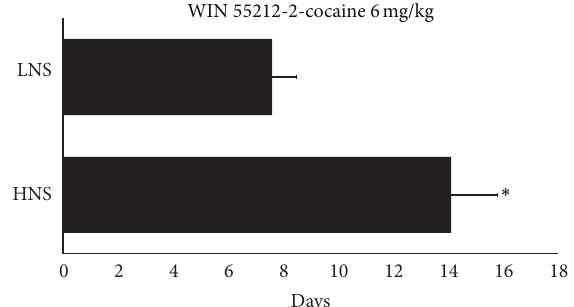
Figure7: Effectsof thenovelty-seeking phenotypeontheextinction of cocaine CPP. Mean number of days needed to achieve complete extinction of CPP in HNS and LNS mice. After conditioning with 6 mg/kg of MDMA, all groups showed CPP in the Post-C test and underwent daily extinction sessions. HNS mice required more extinction sessions to achieve complete extinction of CPP than LNS mice. ∗ 𝑝 < 0.05 ,significantdifferencewithrespecttotheLNSgroup.